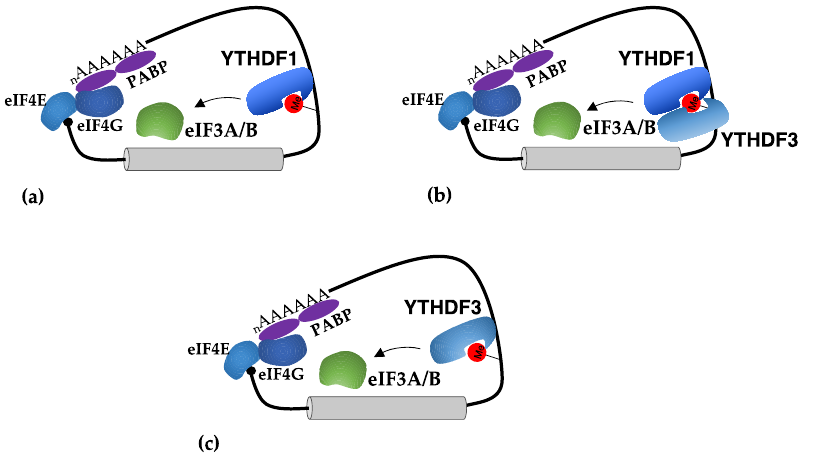
Figure 3. Mechanisms of translational regulation mediated by m 6 A sites in 3 ′ -UTRs. ( a ) The binding of YTHDF1 in m 6 A sites present in the 3 ′ -UTR stimulates translation initiation by recruiting eIF3A and eIF3B; ( b ) the YTHDF3 reader was shown to act in cooperation with YTHDF1 in stimulation of translation; ( c ) in some tumors, YTHDF3 can act independently from YTHDF1 in stimulating translation.